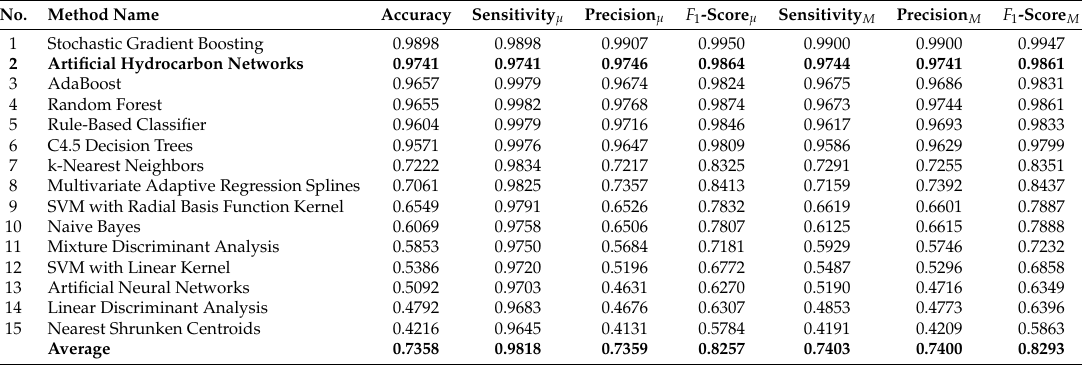
Table 7. Comparison of the supervised classifiers using the reduced dataset of the case study.